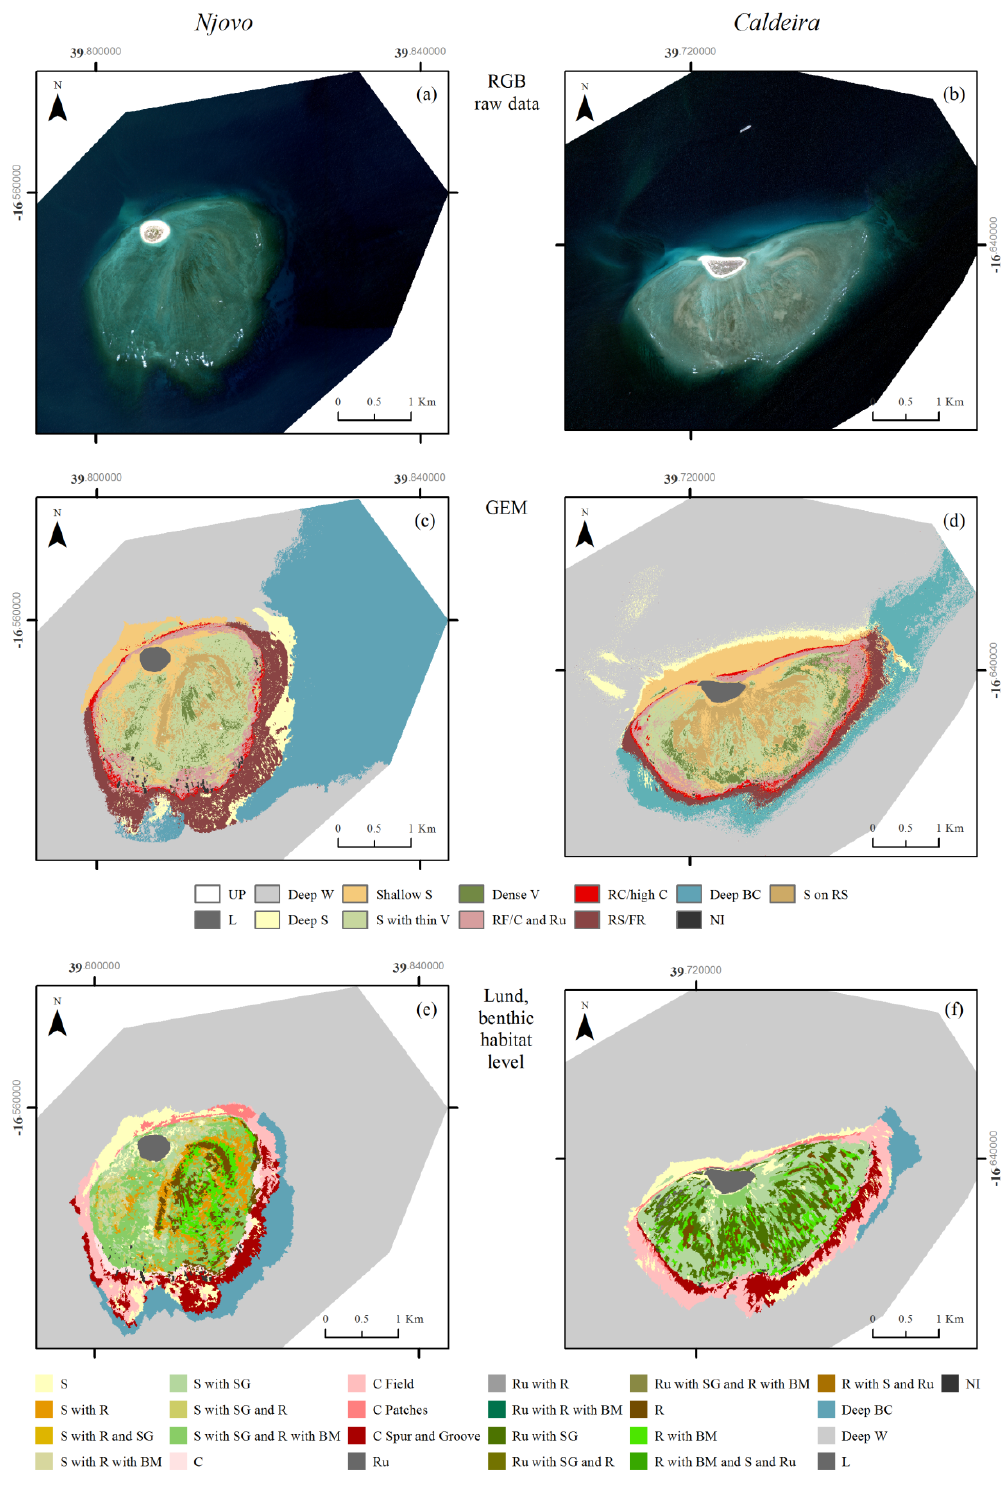
Figure 4. Example of ( a , b ) raw data (min and max percentage clip = 0.2); ( c , d ) GEM and ( e , f ) Lund mapping results for Njovo and Caldeira; BC = benthic cover, BM = brown macroalgae, C = coral, FR = fore reef, L = land, NI = No information, R = rock(s), RC = reef crest, RF = reef front, RS = reef slope, Ru = rubble, S = sand, SG = seagrass, UP=unprocessed,V = vegetation, W = water.